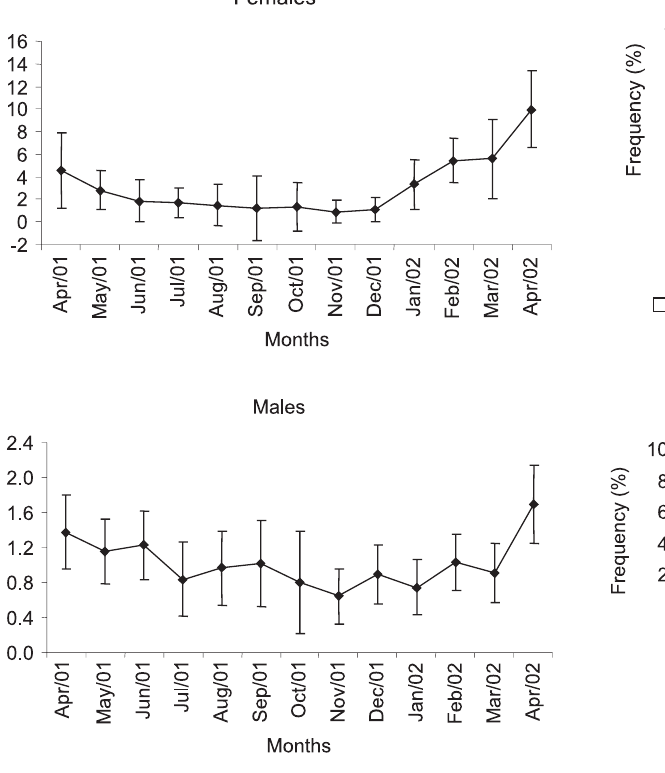
Fig. 2 . Monthly variation of the frequencies of the gonadal maturity stages determined according to macroscopic observation of the gonads for males and females of Serra- pinnus piaba collected in the rio Ceará Mirim from April 2001 to April 2002.